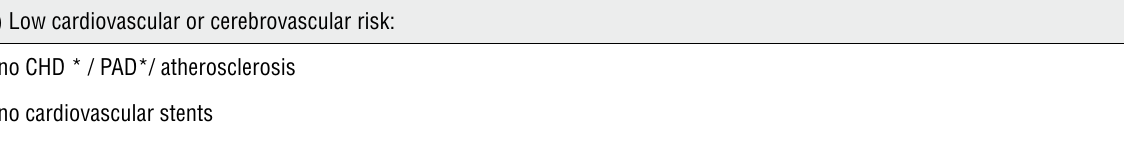
Table 1 - Perioperative platelet inhibition in transurethral